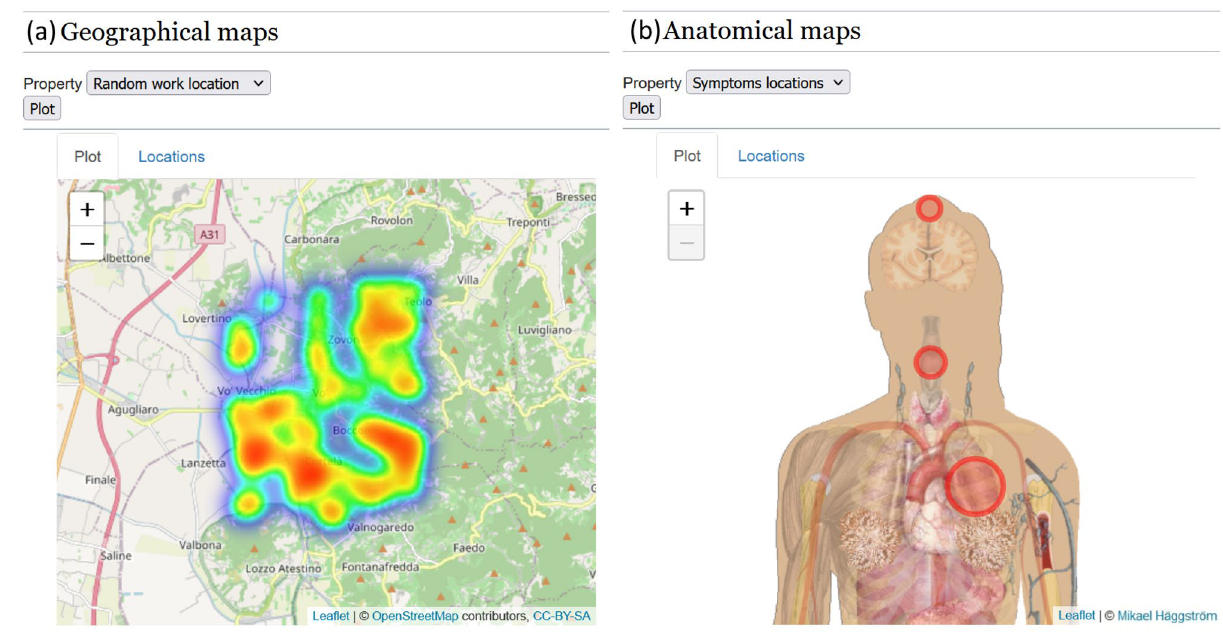
Figure 6. Two examples of maps: ( a ) geographic map with an overlaid heatmap. ( b ) Anatomic map in which placeholders’ radii are proportional to the cardinality of the patients’ sets with specific symptoms